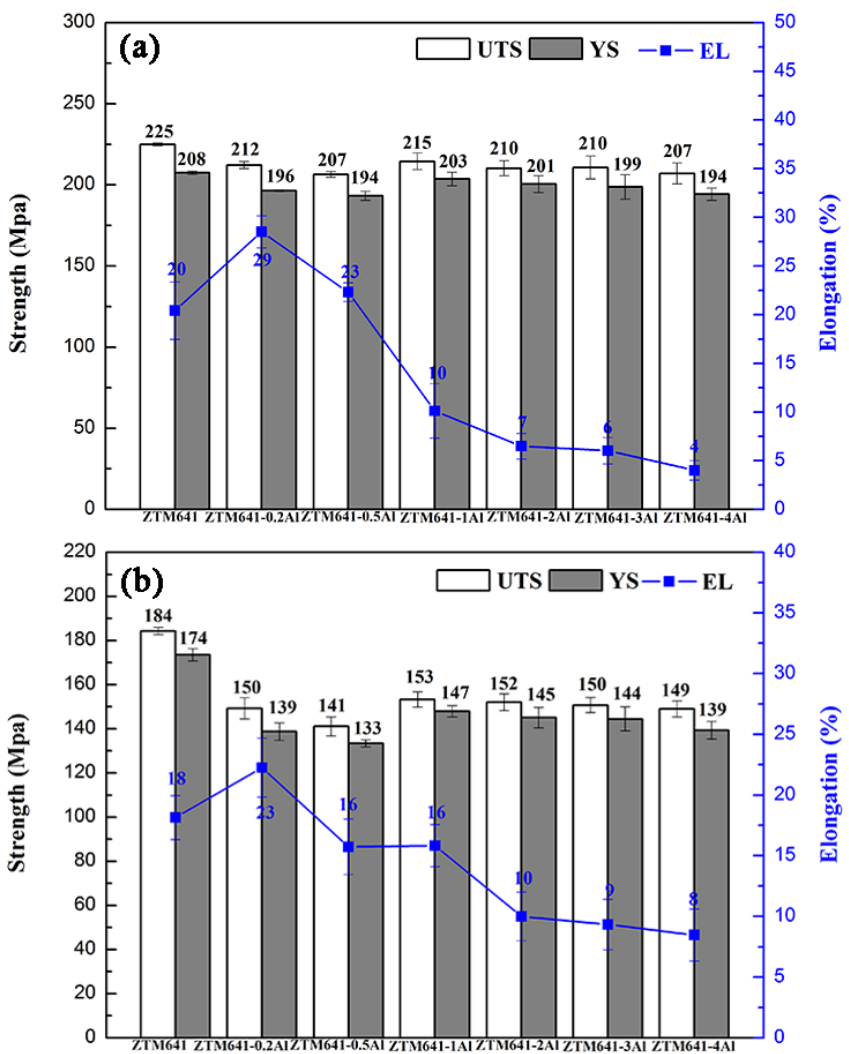
Figure 11. Mechanical properties of the double-aged ZTM641-xAl alloys tested at different temperatures, ( a ) 150 °C and ( b ) 200 °C.